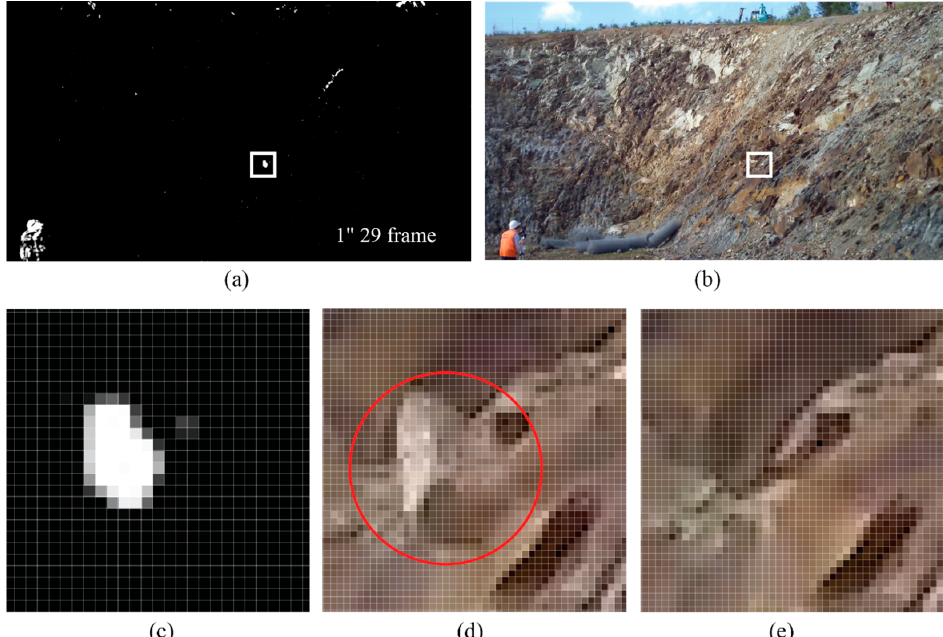
Figure 7. Threshold and highlighted images illustrating rock fragments’ movements along the rockfall trajectory of test #2: ( a ) threshold image; ( b ) moment (1 ″ 29th frame) reached to midpoint; ( c ) enlarged portion of the white box on threshold image; ( d ) enlarged portion of the white box on the original image before rockfall; ( e ) enlarged portion of the white box on the original image at the rockfall moment.